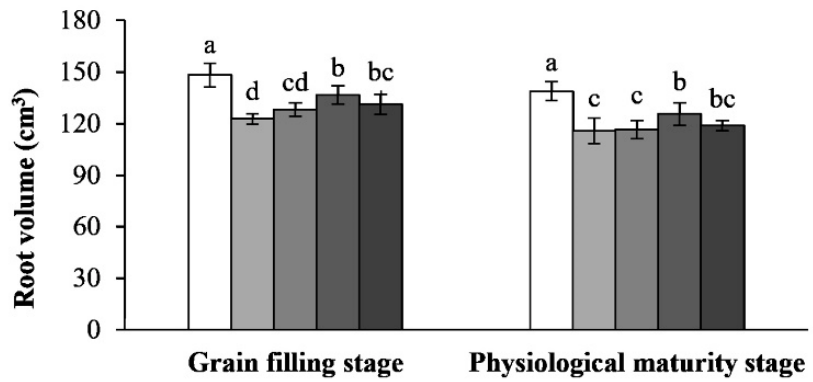
Figure 2. Effects of exogenous spermidine on root characteristic parameters of maize under drought stress. Different letters within the same column indicate significant difference at 5% level.